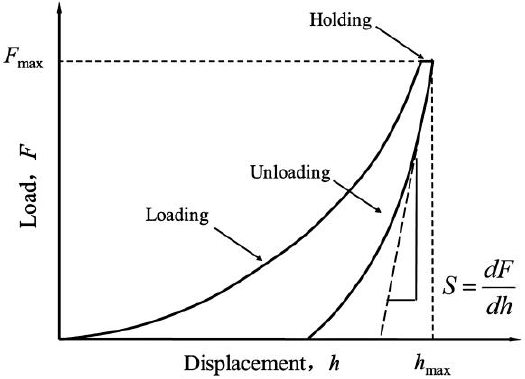
Figure 2. Schematic illustration of nanoindentation loading and unloading processes.